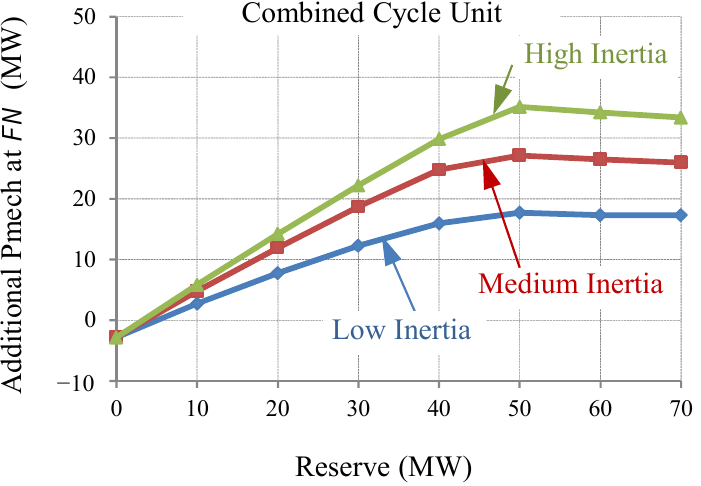
Figure 6. Additional mechanical power of Combined Cycle Unit as response for 350 MW trip, in 3 inertia conditions.